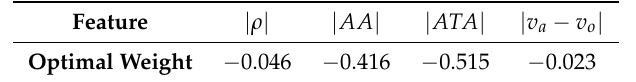
Table 4. The optimal weight w ∗ of the linear combination of aerial combat